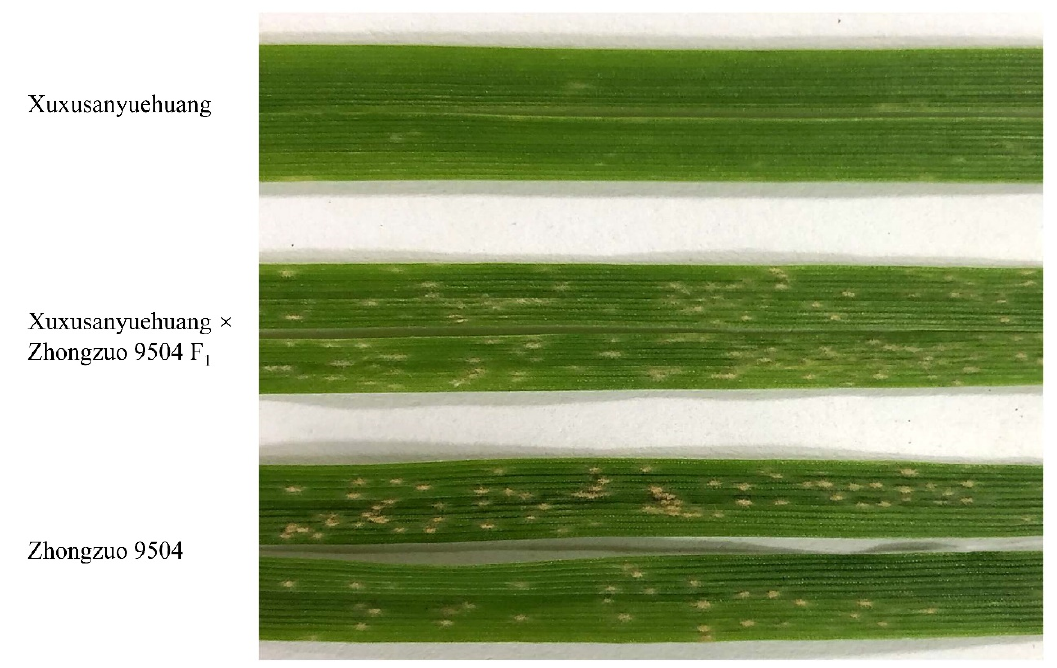
Figure 1. The phenotypic reactions of resistant parent Xuxusanyuehuang, susceptible parent Zhongzuo 9504, and their F 1 plants to isolate Bgt1 .